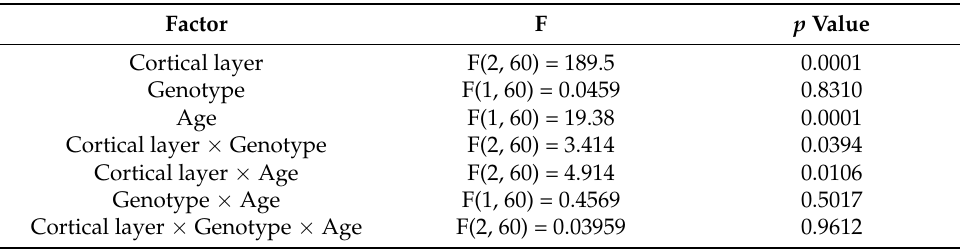
Table A1. Three-way ANOVA of factors influencing NPY-Y1 receptor density on upper motor neurons within the mouse motor